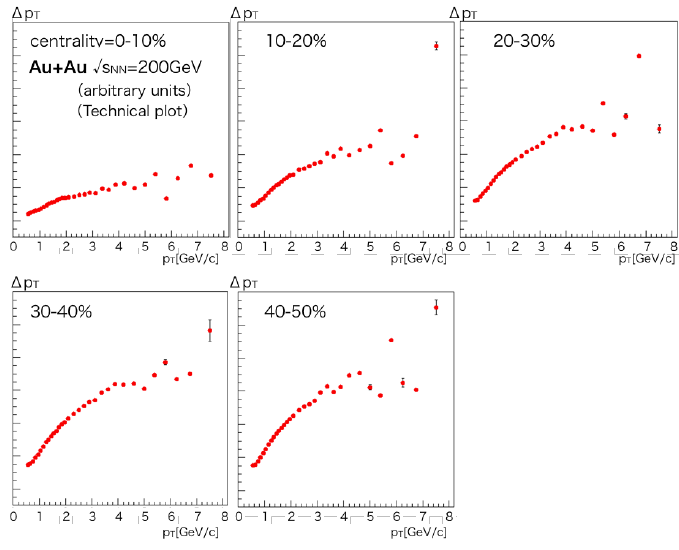
√ s NN = 200 GeV for the centrality region